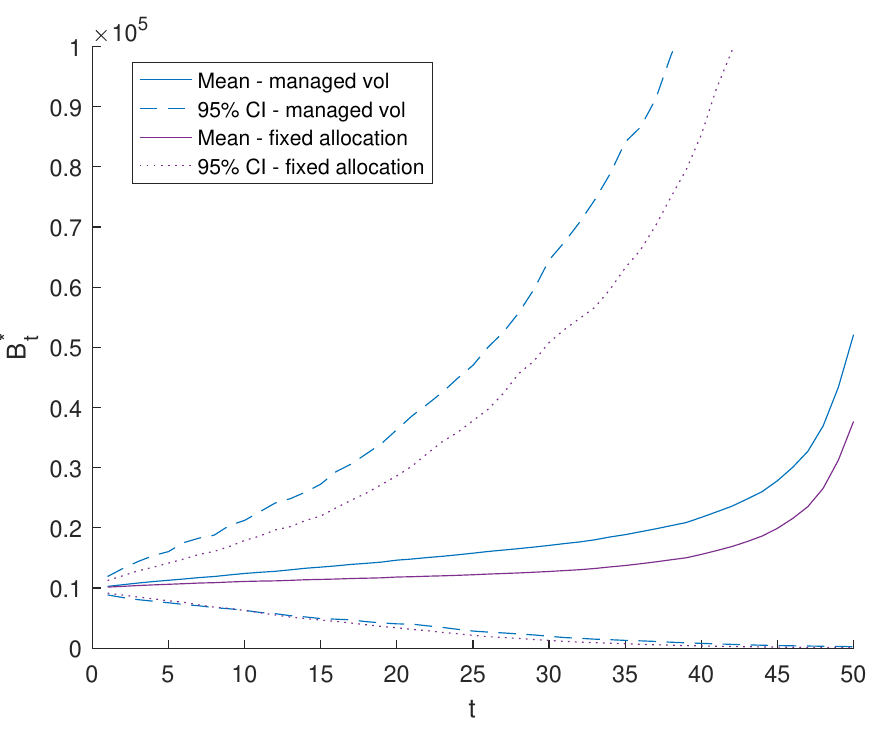
Figure 1. The 95% confidence interval of annuity payments. Managed-Volatility vs. Fixed Allocation (65%/35%)—Nominal.